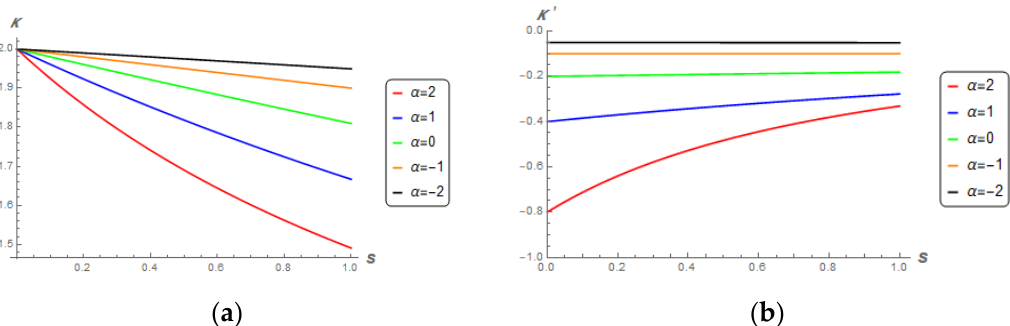
Figure 8. LCG plot of LoCs in maximum principal direction on LA swept surfaces for α = 2 (left) and α = − 1 (right).